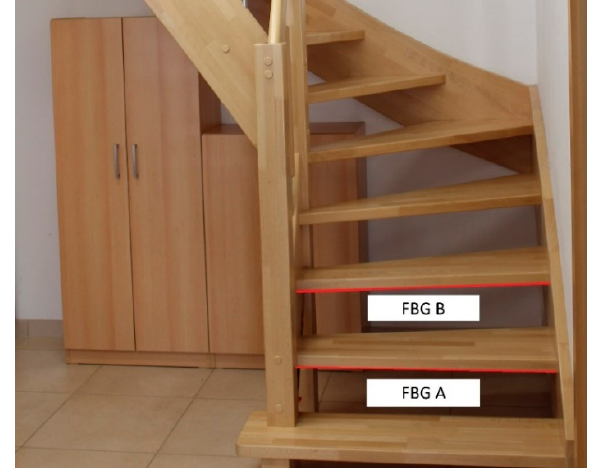
Figure 4. Placement of FBG sensors on the staircase in the smart home (SH), room R104.